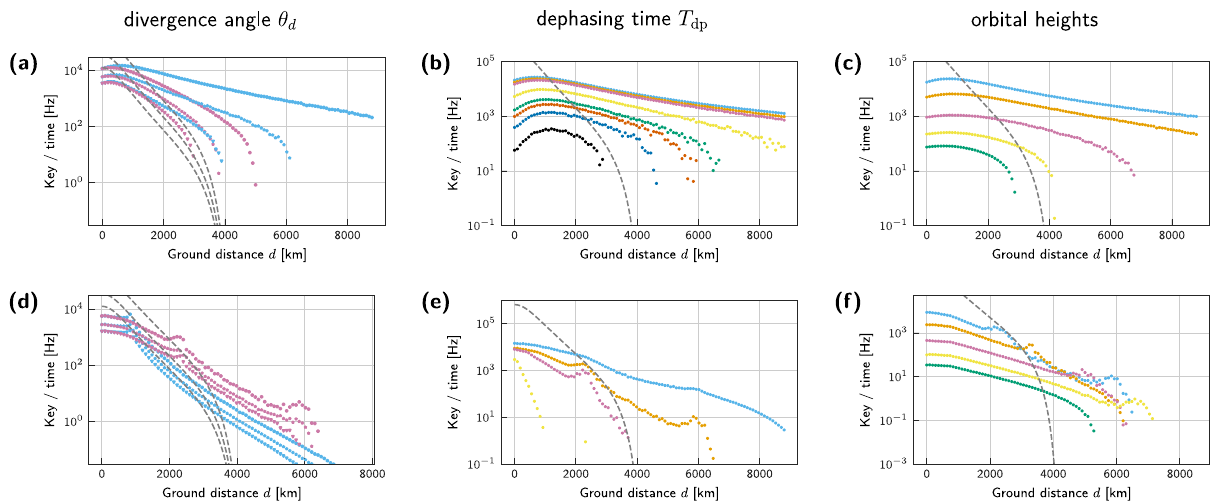
Fig. 4 Exploring variations of the parameters. In each sub fi gure one parameter is varied, while the others are kept at their base value in Table 1. All plots are made for 1000-mode quantum memories. a – c show Scenario 1 (two repeater links), d – f show Scenario 2 (four repeater links). a / d Higher divergence angle θ d = 4, 6, 8 μ rad and therefore higher loss for S A satellite positions 0 (blue) and 0.2 (purple). b / e Various memory qualities with dephasing times T dp of 1 s (blue), 100 ms (orange), 50 ms (pink), 10 ms (yellow), 5 ms (green), 4 ms (red), 3 ms (dark blue), 2 ms (black). c / f Differing orbital heights for all